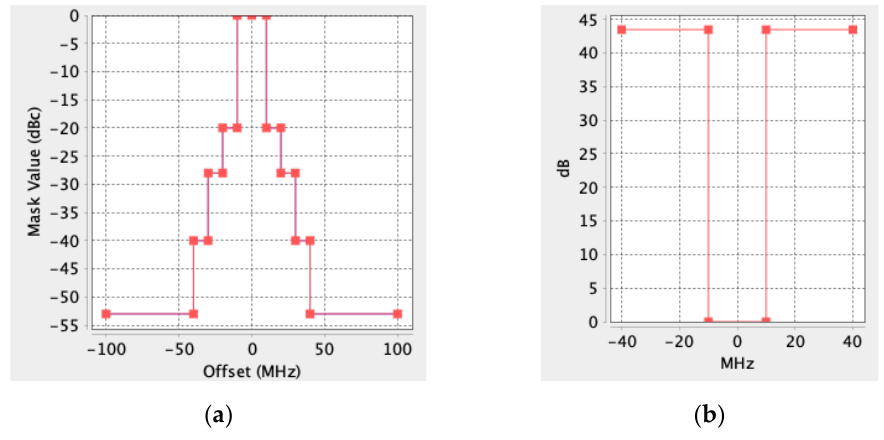
Figure 4. Wi-Fi: ( a ) transmitter emission mask; and ( b ) receiver-blocking mask.